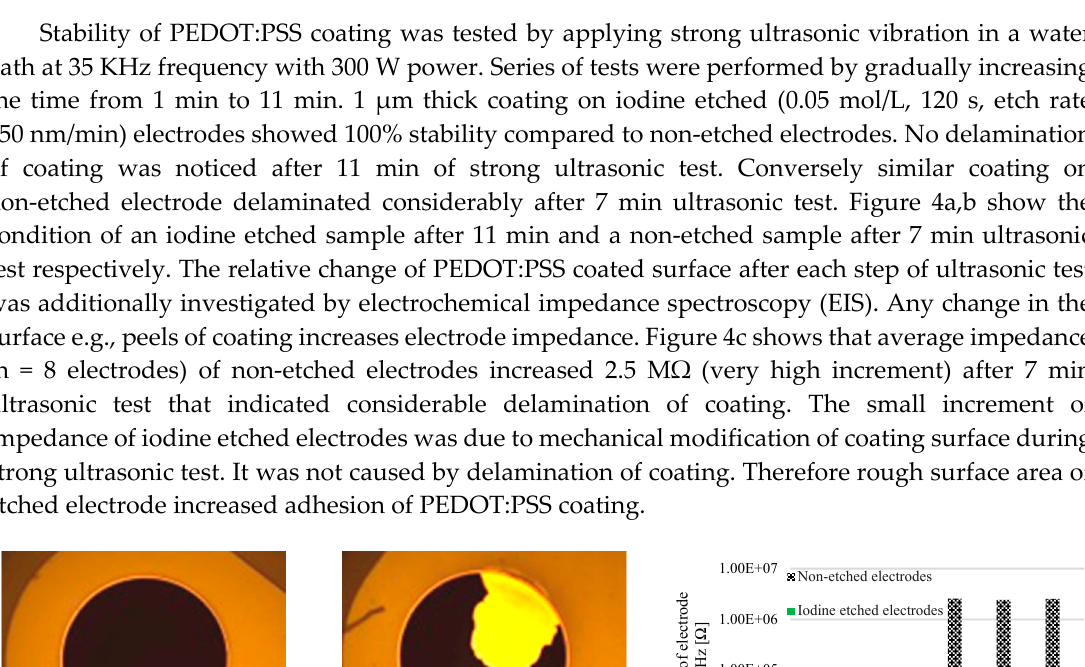
Figure 3. SEM image: ( a ) gold surface without etching; ( b ) Porous surface after iodine etching; ( c ) Bonding between PEDOT:PSS and iodine-etched gold surface (vertical cut through electrode).